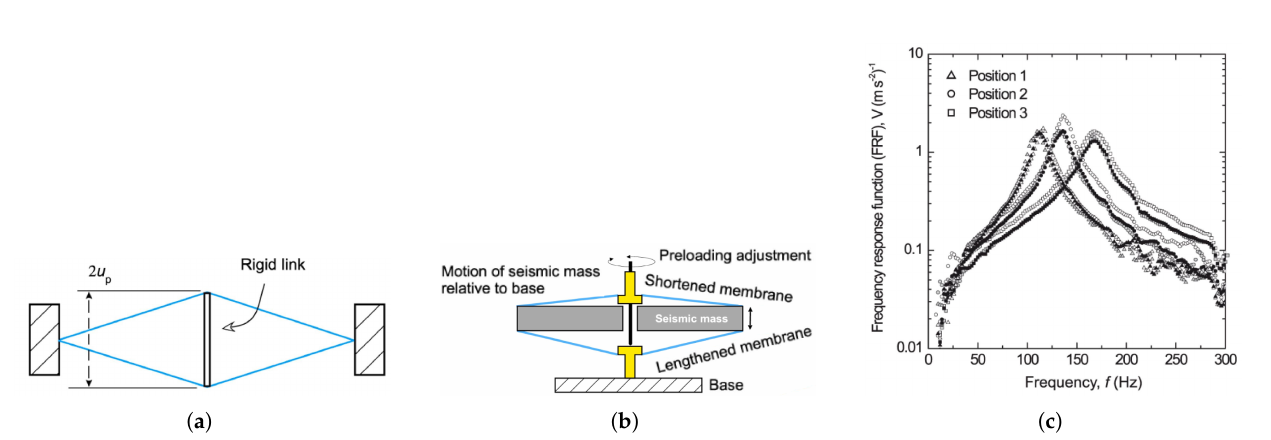
Figure 24. Frequency tunable piezoelectric XMR harvester proposed by Morris et al. [90] (figure taken from [89] with permission); ( a ) basic concept (without seismic mass); ( b ) cross-sectional schematic when driven by base excitation; ( c ) frequency response for different